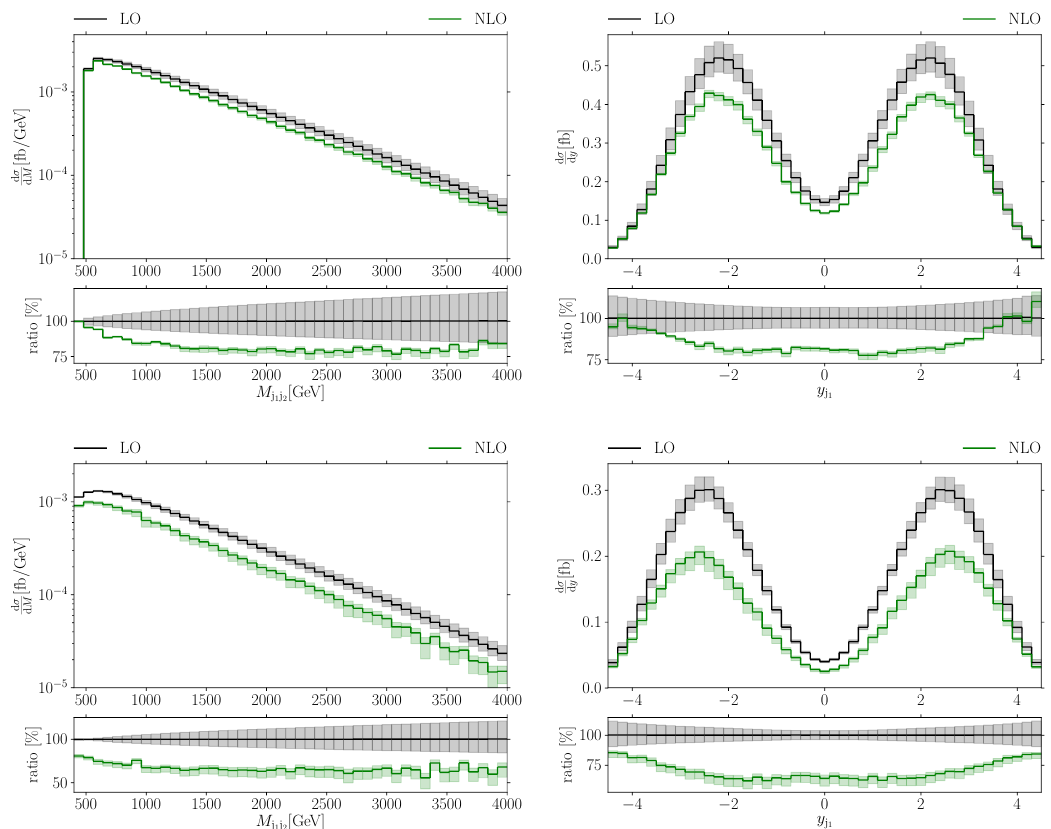
Figure 13. Differential distributions at LO and NLO in the invariant mass of the two tagging jets (left) and the invariant mass of the charged-lepton pair (right) in the VBS setup (top) and the Higgs setup (bottom). The upper panels show the absolute EW contribution at (cid:0) (cid:1) (cid:0) (cid:1) (cid:0) (cid:1) contribution α 6 + α 7 + α s α 6 , the lower panels the relative corrections. Shaded bands O O O indicate the 7-point scale